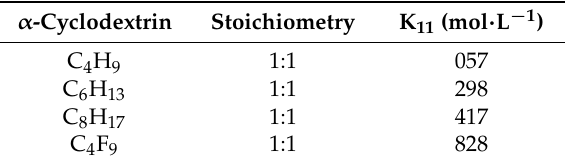
Table 1. Stoichiometry and stability constants (K 11 ) of complexes in ethanol. α -Cyclodextrin